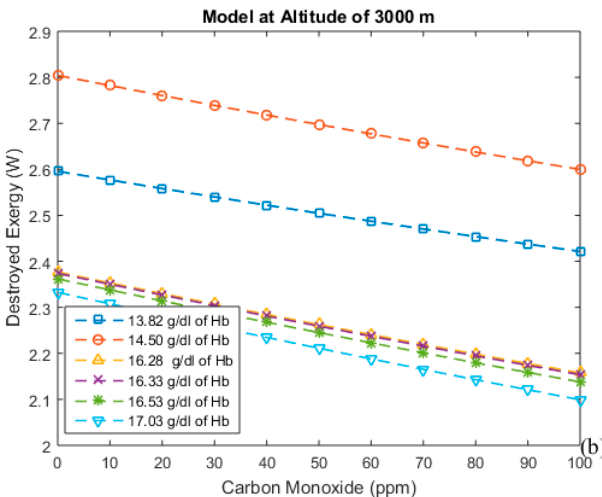
Figure 6. ( a ) Exergy efficiency and ( b ) destroyed exergy as functions of carbon monoxide and hemoglobin concentration at 3000 m.